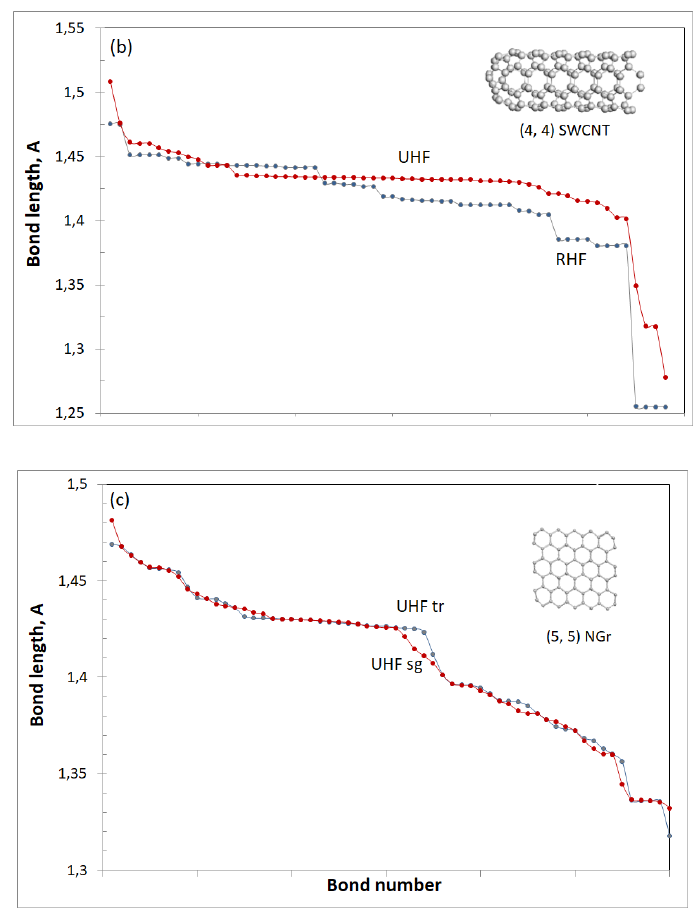
Figure 1. Z → A distributions of sp 2 C=C bonds in fullerene C 60 ( a ), a fragment of (4, 4) SWCNT ( b ), and nanographene molecule (5, 5) NGr ( c ). Calculations are performed using CLUSTER-Z1 software implementing AM1 semi-empirical HF approximation [42]. Closed-shell version of the study is presented by the RHF solutions.